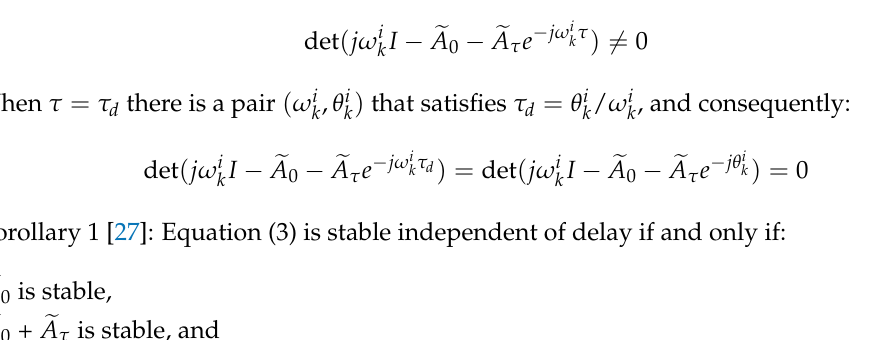
Figure 2. A single-machine-infinite-bus power system with an exciter.